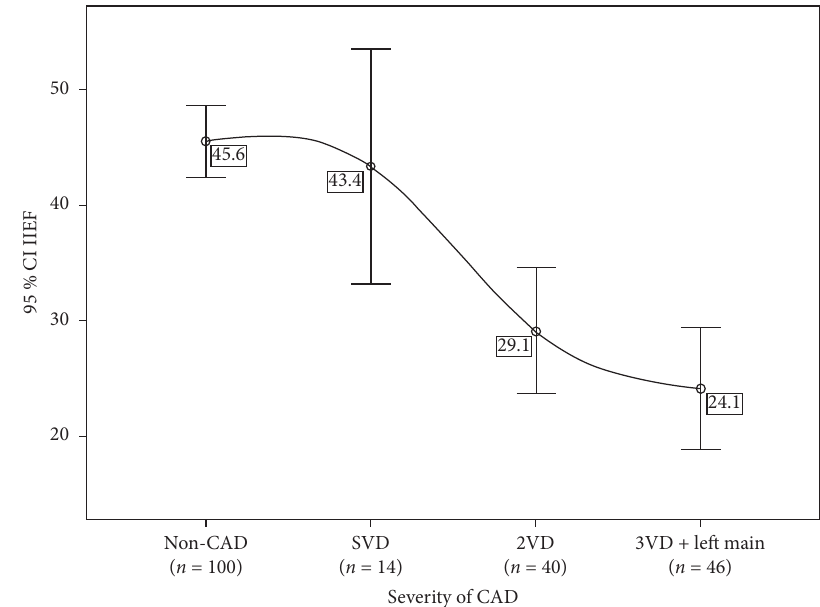
Figure 1: Mean score of IIEF in the non-CAD group and 3 CAD groups. CAD, coronary artery diseases; SVD, single-vessel disease; 2VD, two-vessel disease; 3VD, three-vessel disease. We indicate severity of CAD according to number of involved vessels. Figure shows that as CAD becomes more severe, mean of IIHF decreases, and severity of ED